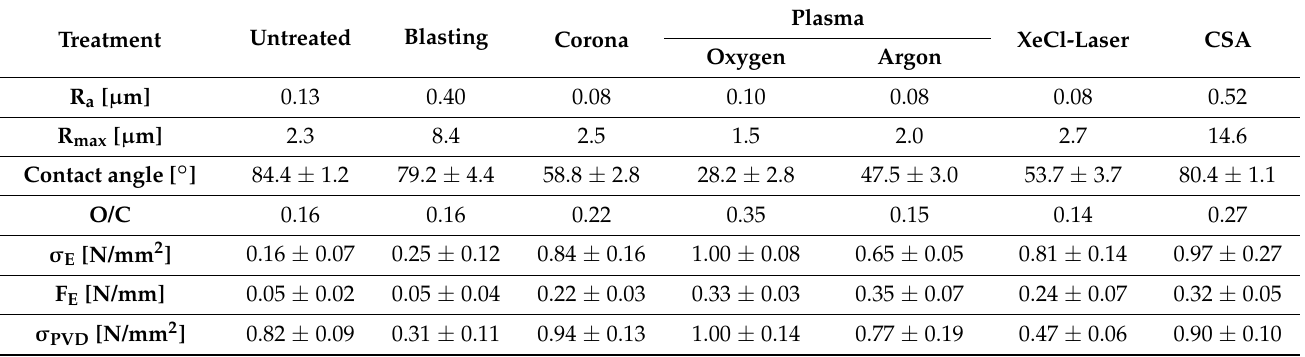
Table 1. Effect of various treatments on surface properties of a PEEK film and its adhesion to